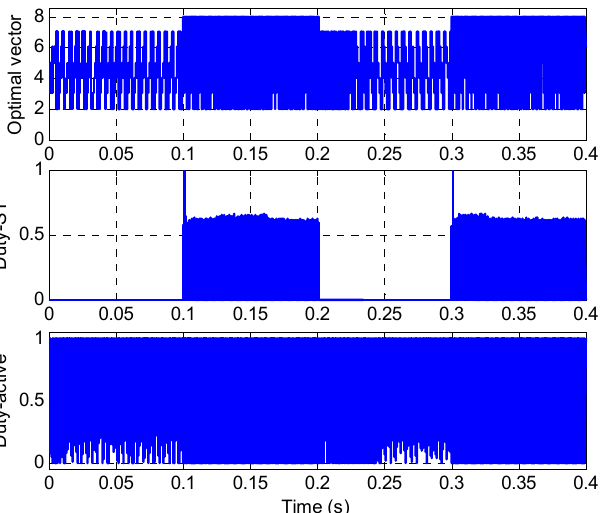
Figure 9. Control signals with the modulated FCS-MPC. From top to bottom: optimum voltage vector, optimal duty at shoot-through state, and optimal duty at active state.